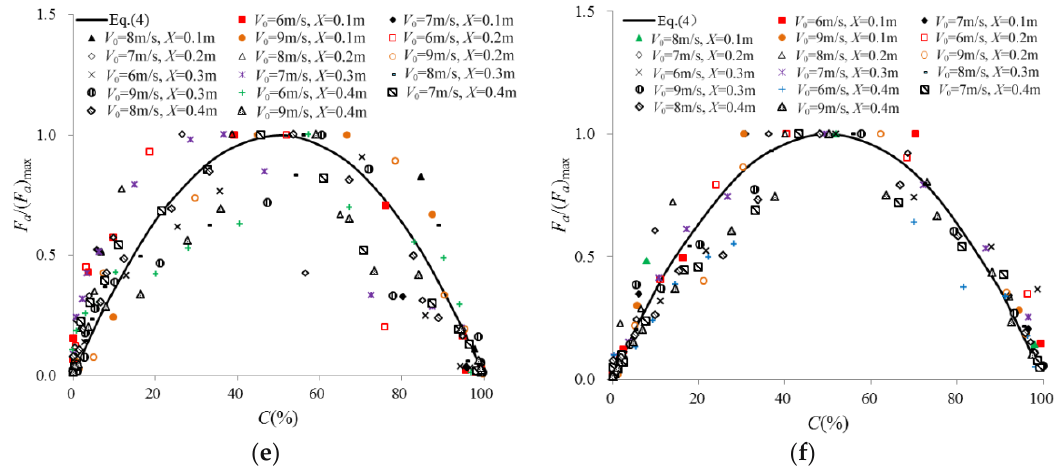
Figure 7. Dimensionless air bubble frequency as a function of the air concentration fitted with Equation (4). Upper nappe ( a ) ( h , b ) = (4.5 cm, 4.5 cm), θ = 25%. ( b ) ( h , b ) = (6.5 cm, 6.5 cm), θ = 10%; lower nappe ( c ) ( h , b ) = (4.5 cm, 4.5 cm), θ = 25%. ( d ) ( h , b ) = (6.5 cm, 6.5 cm), θ = 10%; side nappe ( e ) ( h , b ) = (4.5 cm, 4.5 cm), θ = 25%. ( f ) ( h , b ) = (6.5 cm, 6.5 cm), θ = 10%.